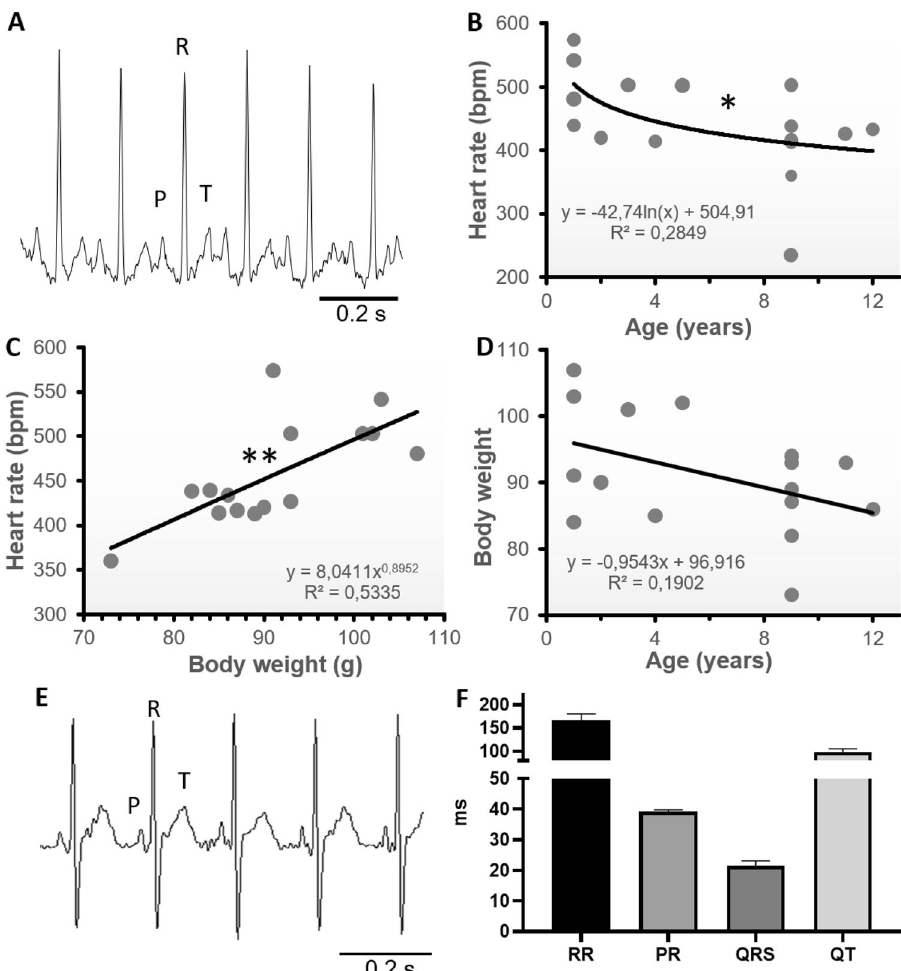
Figure 2. Cardiac activity of GML on surface ECG or during anesthesia, and correlation between HR, age and body weight. ( A ) Electrocardiograms from surface ECGs. Note P, R and T waves. ( B ) Correlation between HR and age in freely moving GML (n = 16); significant by Pearson or Spearman correlation coefficients (*p < 0.05), it respect the normal distribution according to d’Agostino and Pearson test, or Kelmogorov-Smirnov test (*p < 0.05). ( C ) Correlation between HR and body weight in freely moving GML (n = 15); significant by Pearson or Spearman correlation coefficients (**p < 0.01 and *p < 0.05, respectively), it respect the normal distribution according Kelmogorov-Smirnov test (*p < 0.05). One couple of extreme value was excluded from this correlation analysis. ( D ) Correlation between body mass and age (n = 16); Non-significant by Pearson or Spearman correlation coefficients, does not respect the normal distribution. ( E ) Electrocardiograms from anaesthetized GMLs. Note P, R and T waves. ( B ) Interval between successive heartbeats (RR), interval between atrial and ventricular depolarization (PR), length of the ventricular depolarization (QRS) and interval between ventricular depolarization and repolarization (QT) characterizing the ECG waveform of anaesthetized GMLs (n =